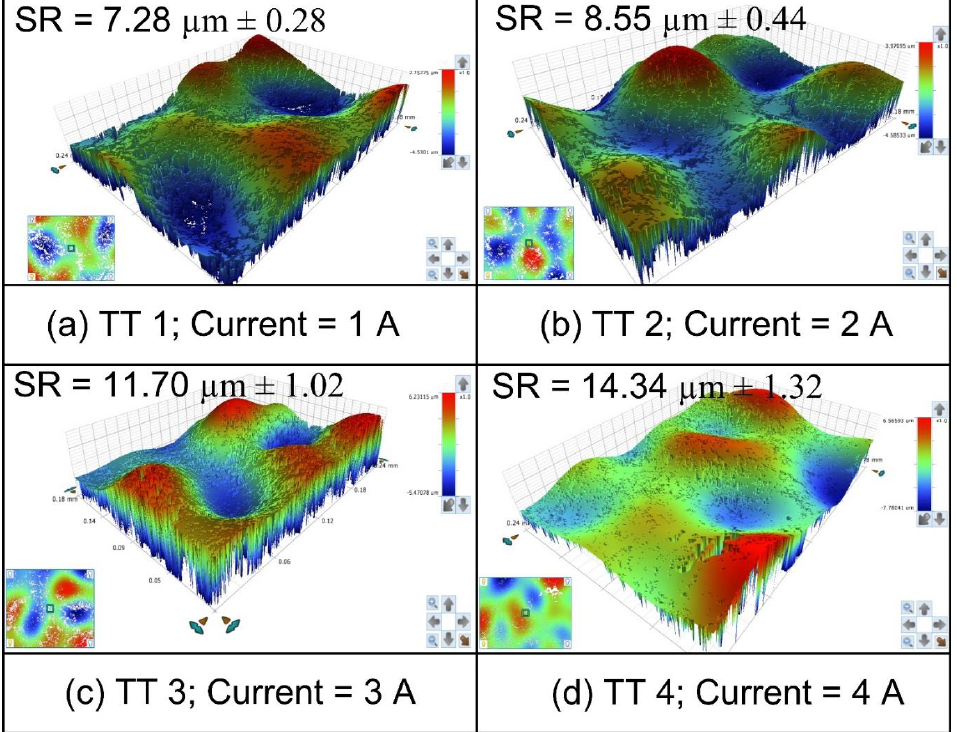
Figure 6. Effect of applied current values on the surface roughness of tools (a) current = 1A, (b) current = 2A, (c) current = 3A, and (d) current = 4A.